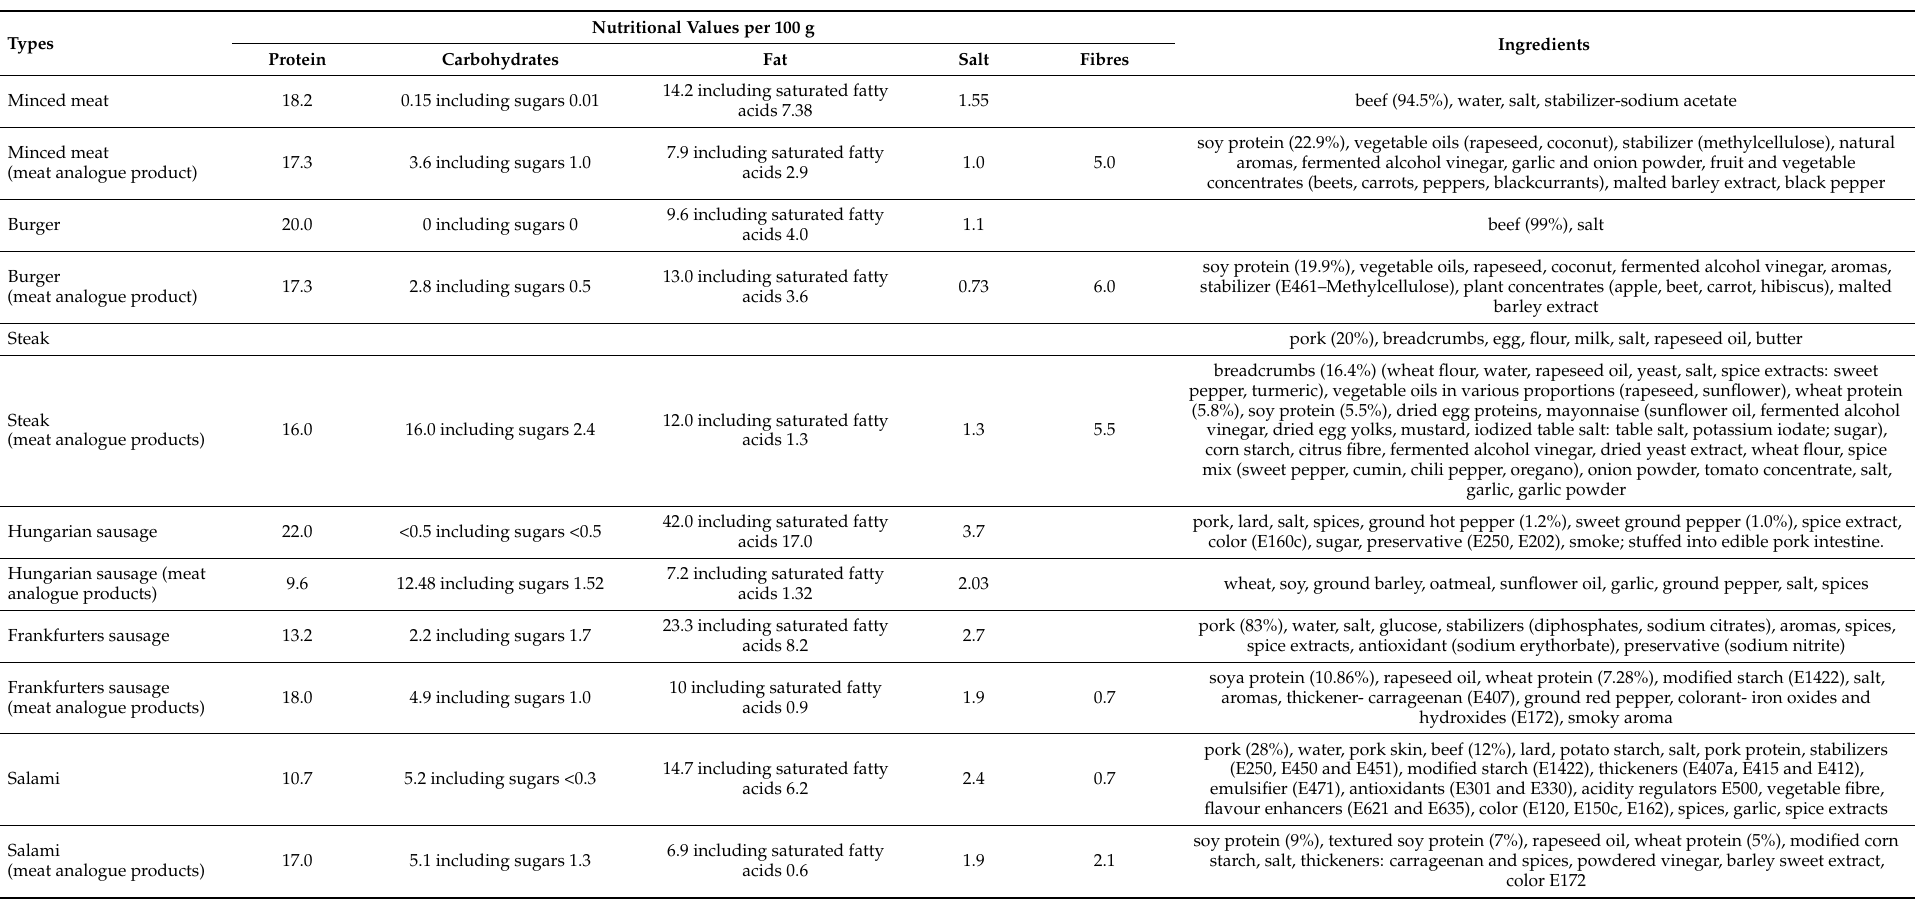
Table 1. The main composition (in g/100 g) of meat conventional